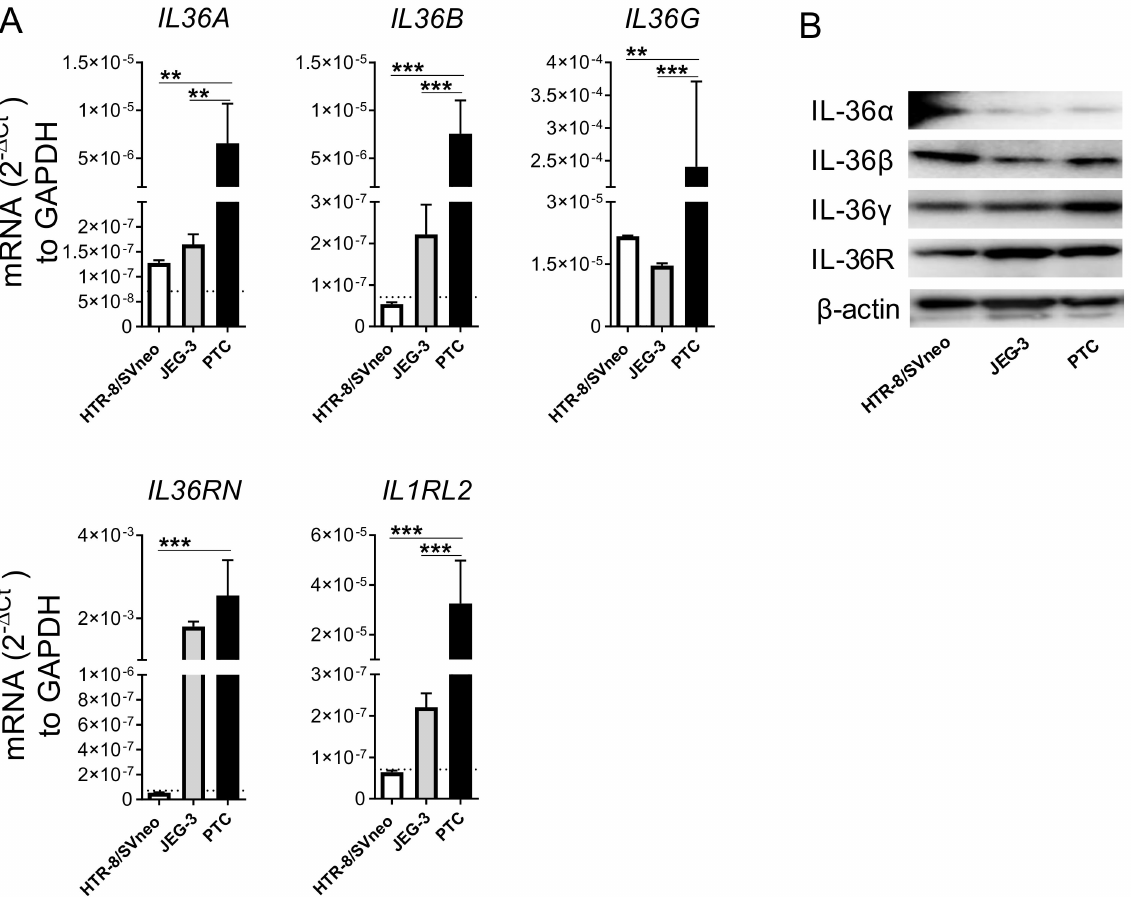
Figure 1. Expression level of IL-36 family members in trophoblast cell models. Trophoblastic cell lines HTR-8/SVneo and JEG-3, and primary trophoblast cells (PTC) from normal placentas were cultured under standard conditions. ( A ) The mRNA levels for IL-36 transcripts were determined by quantitative real-time PCR and normalized using the 2 − ∆ Ct method against Glyceraldehyde 3-phosphate dehydrogenase (GAPDH). PCR results from three independent experiments are shown as mean ± SEM. The horizontal dotted lines denote detection limit (Ct > 40; if not visible it overlaps with the x-axis). One-way ANOVA with Bonferroni’s multiple comparison test. ** p < 0.01, *** p < 0.001. ( B ) IL-36 ( α , β , γ ), IL-36R, and β -actin protein detected by Western blotting using 20 µ g of respective cell